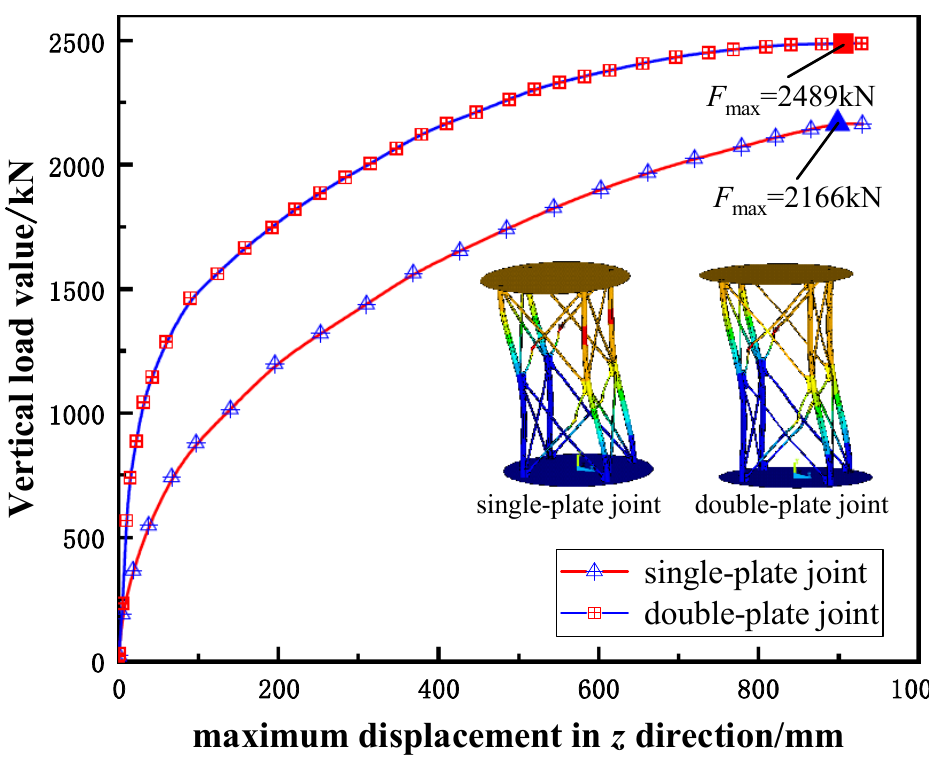
Figure 18. Load displacement curve of tower bearing capacity.